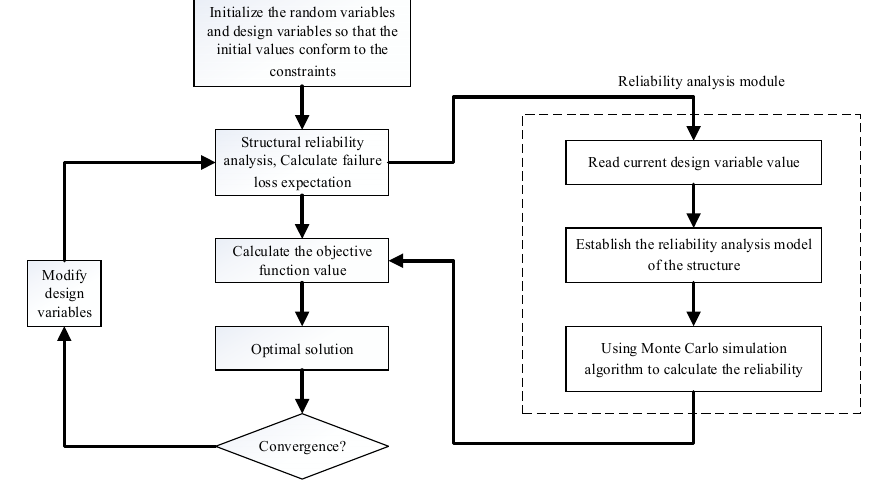
Figure 5. The flow chart of the optimization design of an SRHPC frame structure.